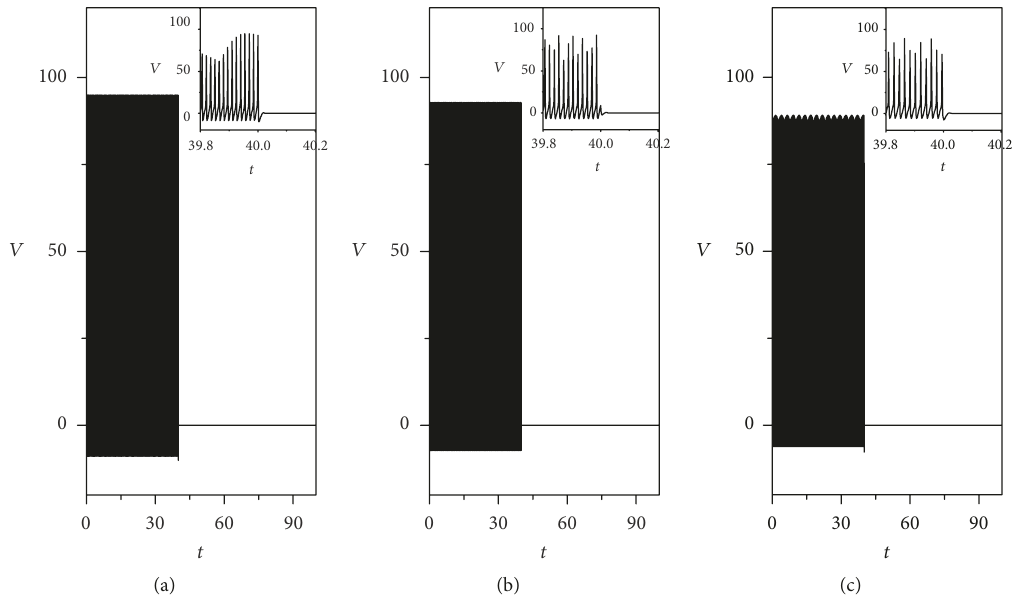
Figure 4: Sampled time series for membrane potential of neuron are calculated when neuron is coupled by astrocypte and autapse driving with negative feedback is considered at 𝜏 = 2 , for (a) 𝑔 𝑒 = 0.1 , (b) 𝑔 𝑒 = 0.5 , and (c) 𝑔 𝑒 = 1.0 . The parameter is set as 𝑟 IP figures are enlarged ones. And the external forcing current regulates the neuron by 𝐼 ext = 10.0 𝜇 mol/L ⋅ cm 2 at 𝑡 < 40 s. The inserted figures are enlarged to show the sampled time series for membrane potential from 𝑡 = 39.8 to 40.2 ms.